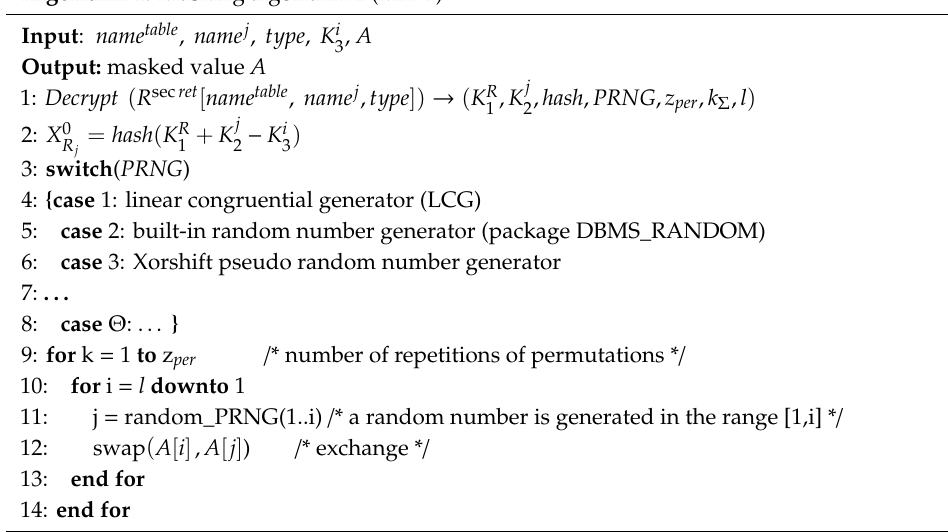
Algorithm 1. Masking algorithm 1